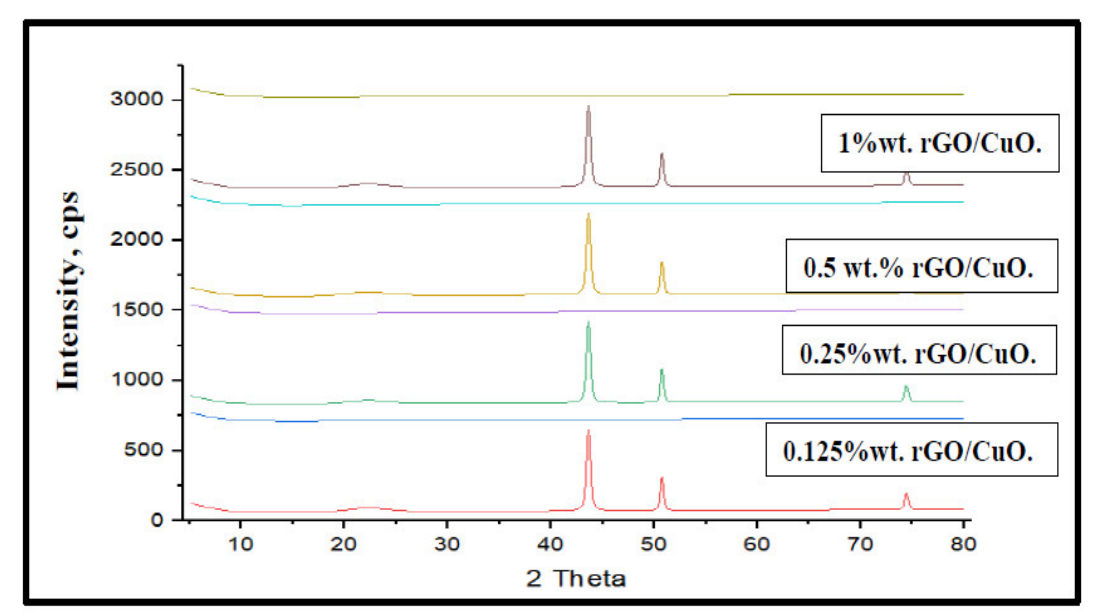
Figure 1. XRD patterns rGO/CuO composites at different rGO wt.%, at room temperature. Table 1. XRD of rGO/CuO. 2 ϴ